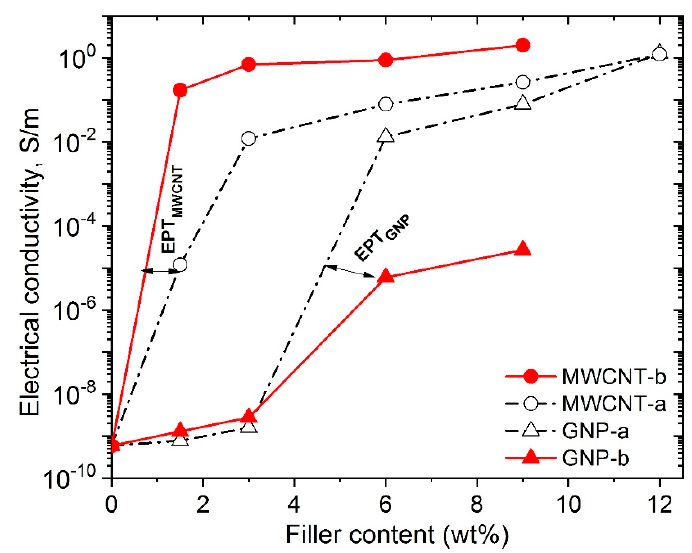
Figure 7. Electrical conductivity vs. filler content for the MWCNT-a, MWCNT-b, GNP-a and GNP-b nanocomposites. Arrows show EPT, which coincide with rheological percolation threshold.